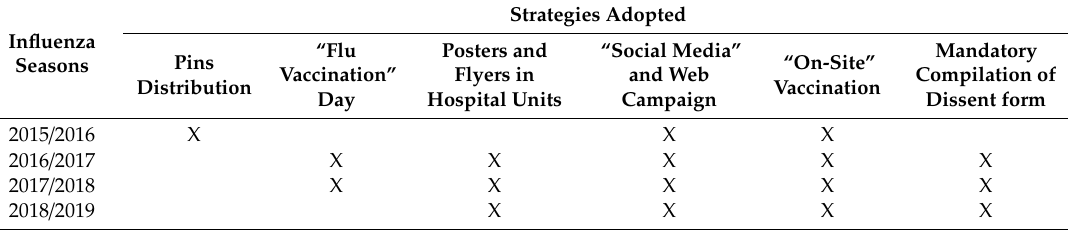
Table 1. Strategies adopted by the University Hospital of Palermo to increase influenza vaccination coverages among health care workers (HCWs) in the last four influenza seasons. Strategies Adopted Influenza Posters and Pins Seasons Flyers Distribution